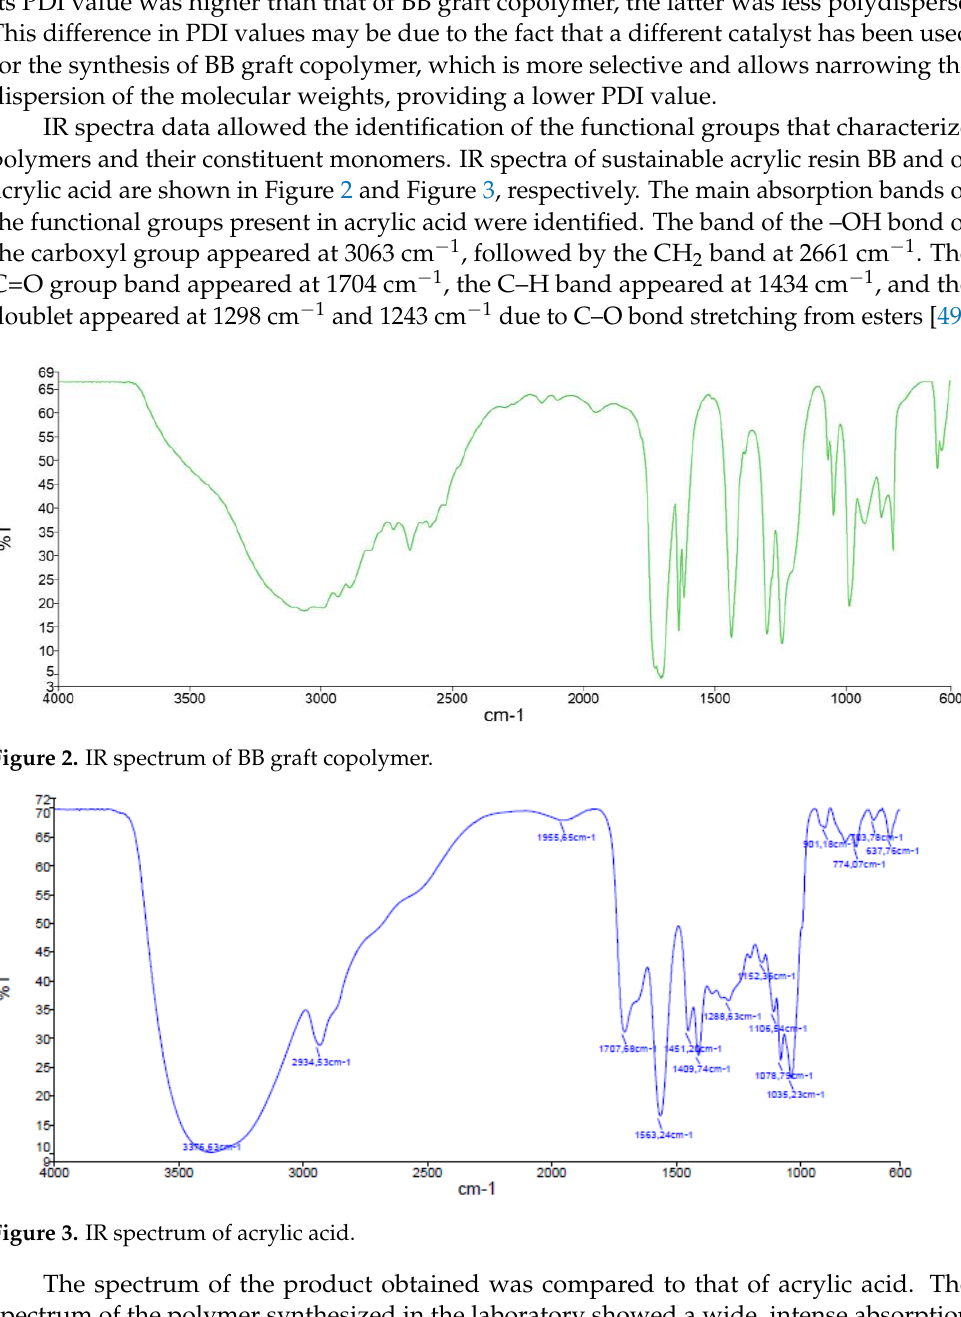
Table 3. Number average molecular weight, weight average molecular weight, and polydispersity